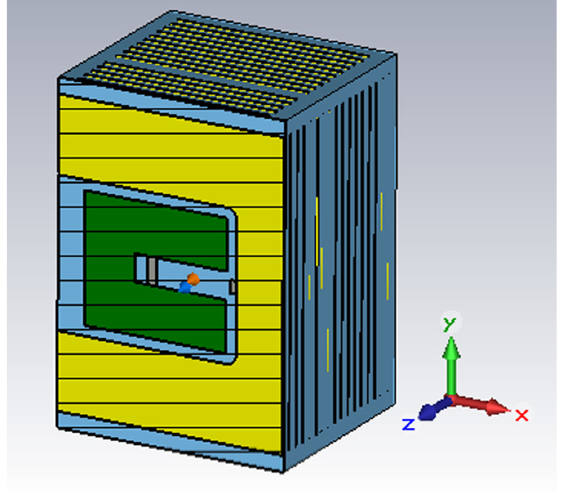
FIG. 4. Transverse section view of a ferrite-loaded delay line kicker model used for CST simulations of KFA13. The kicker is made of three identical modules. In each module the ferrite (in green) is split longitudinally in nine cells. Each cell is 24 mm long: 19 mm of ferrite and 5 mm of aluminium (in yellow). In each module there are two conducting cables, modeled in CSTwith PEC (perfectly conducting boundaries, in grey). Vacuum is represented in light blue. This model has been discretized in CST with 7,588,152 mesh cells and simulated with a wake length of 25